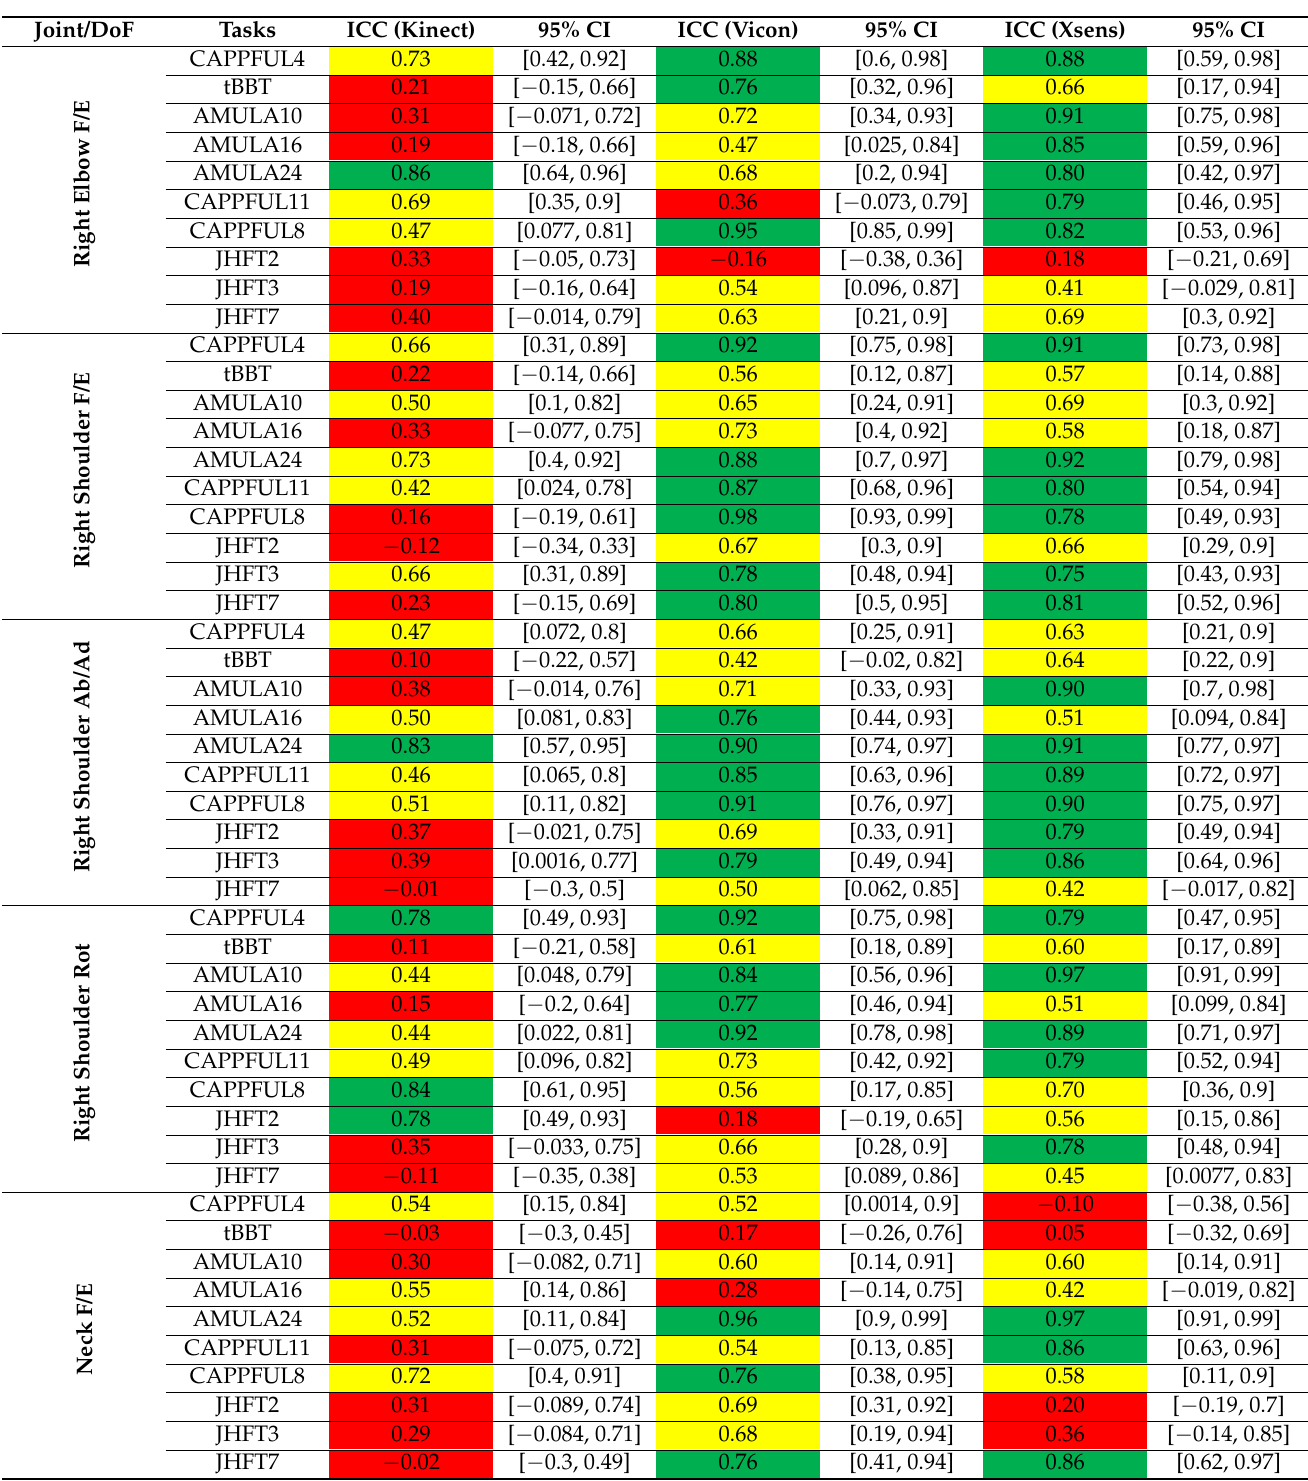
Table 2. ICC values with 95% confidence intervals for each DoF, task, and motion system comparison. Red cells indicate a weak correlation (ICC < 0.4). Yellow cells indicate a moderate